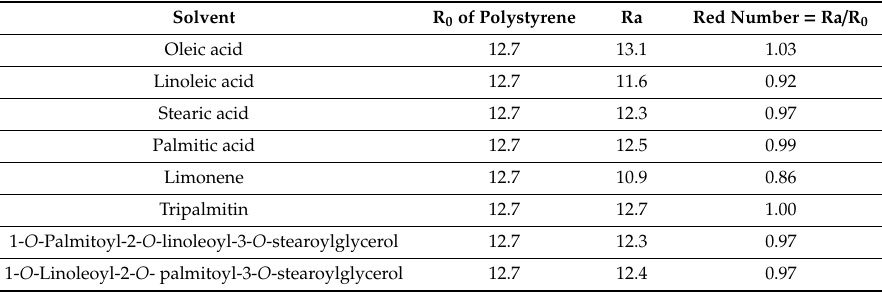
Table 5. Relative energy di ff erence (RED) of polystyrene for vegetable